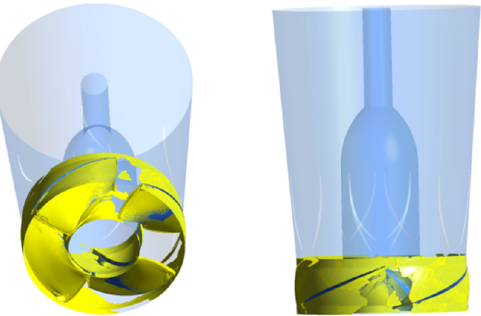
Figure 7. The area of sheer strain rate exceeding the threshold in the impeller.